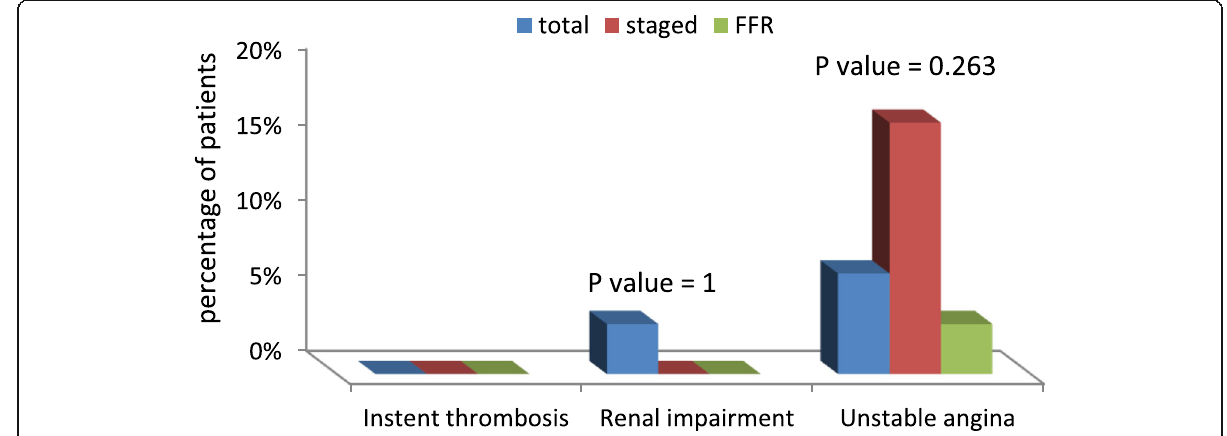
Fig. 2 The short-term outcome in the three